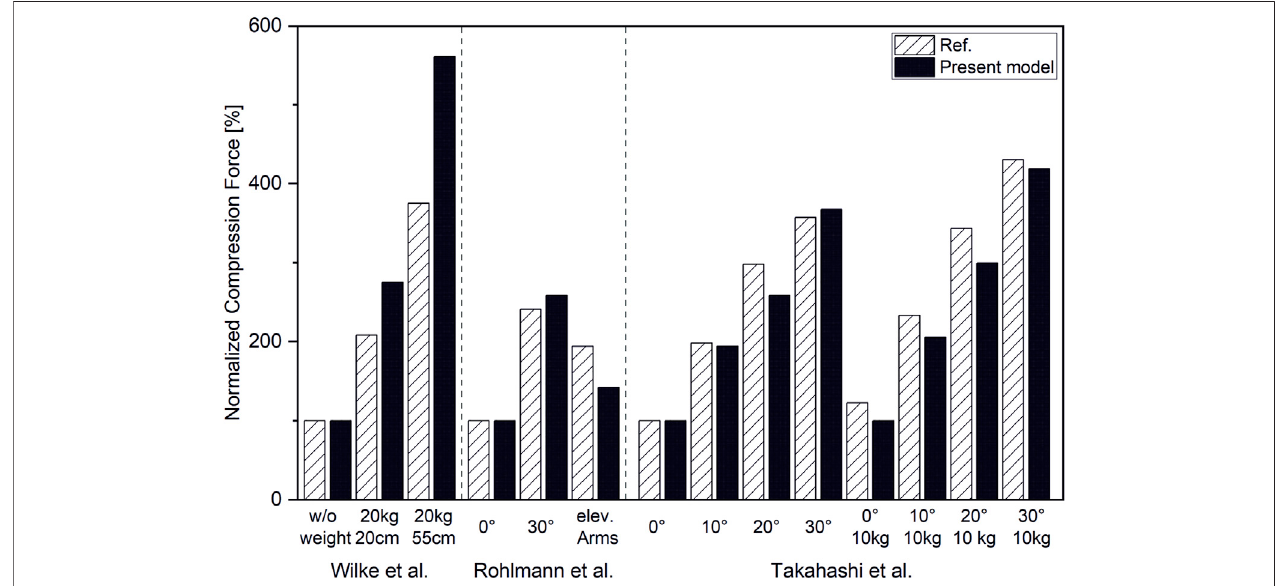
FIGURE 10 | Compression forces normalized to respective forces in upright standing position for L4/L5 (Wilke et al., 2001; Takahashi et al., 2006) and T12/L1 (Rohlmann et al., 2008).